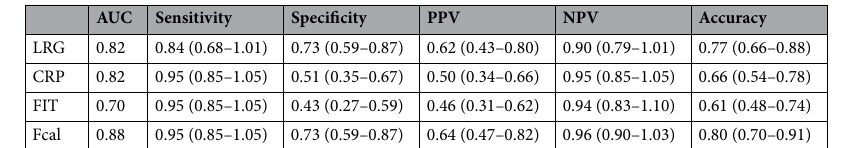
Table 4. Sensitivity, specificity, and predictive values of the serum/fecal biomarkers for mSES-CD 0 in CD patients. mSES-CD modified simple endoscopic score for Crohn’s disease, CD Crohn’s disease, AUC area under curve, PPV positive predictive value, NPV negative predictive value, LRG leucine-rich alpha-2 glycoprotein, FIT fecal immunochemical test, Fcal fecal calprotectin, CRP C-reactive